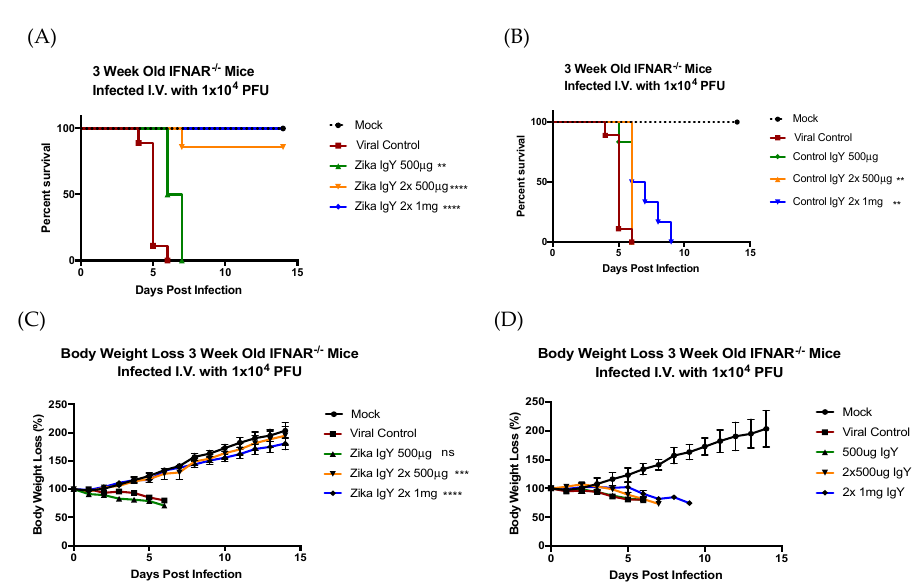
(D) Figure 2. Anti-ZIKV IgY neutralizes ZIKV in vitro without antibody-dependent enhancement. ( A ) Anti-ZIKV IgY neutralized the ZIKV infection in vitro with a NT 50 of 25 µg/mL. ( B ) Purified anti- ZIKV IgY did not enhance the ZIKV infection in vitro at 100 µg/mL. ( C ) Purified anti-ZIKV IgY did not enhance the DENV2 infection in vitro at 100 µg/mL, whereas 4G2 flavivirus IgG significantly enhanced the viral load. ( D ) Purified anti-ZIKV IgY did not enhance the ZIKV infection in vitro at any level tested, whereas 4G2 flavivirus IgG significantly enhanced the viral load at 1, 10, and 100 µg. **** p < 0.0001, ns = not significant. 3.3. In Vivo Efficacy of ZIKV-Specific IgY IFNAR − / − mice were challenged with a lethal dose of ZIKV PRVABC59 (1 × 10 4 PFUs), and the therapeutic potential of ZIKV-specific IgY was determined (Figure 3). The results of four independent experiments using a lethal dose of 1 × 10 4 PFUs were combined. The mice receiving only PBS as a negative control succumbed to infection by 6 days postinfection. An initial dose of 500 µg of ZIKV- specific IgY ( n = 6) 24 h postinfection significantly extended the lifespan but did not allow for recovery from the infection, and all mice succumbed to infection by day 7. Five hundred µg of ZIKV-specific IgY ( n = 9) administered 24 and 48 h postinfection led to an 85% therapeutic efficacy. This dose significantly reduced the infectious viral load and genomic viral copies in the brain, liver, and spleen (Figure 4). We achieved a 100% therapeutic efficacy with 1 mg of ZIKV-specific IgY ( n = 6) administered 24 and 48 h postinfection. This regimen resulted in a sterilizing immunity in all mice